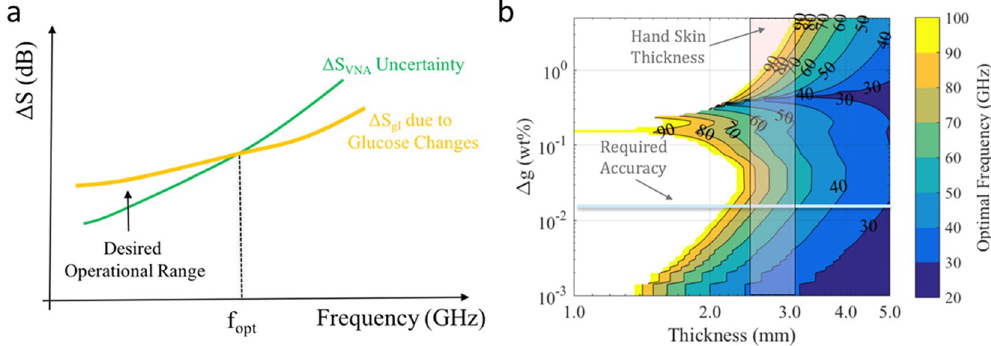
Figure 2. Sensitivity and optimal frequency of operation. ( a ) Optimal frequency operating range considering difference in transmission coefficient and system uncertainty. ( b ) Optimal frequency of operation for different glucose concentrations and sample